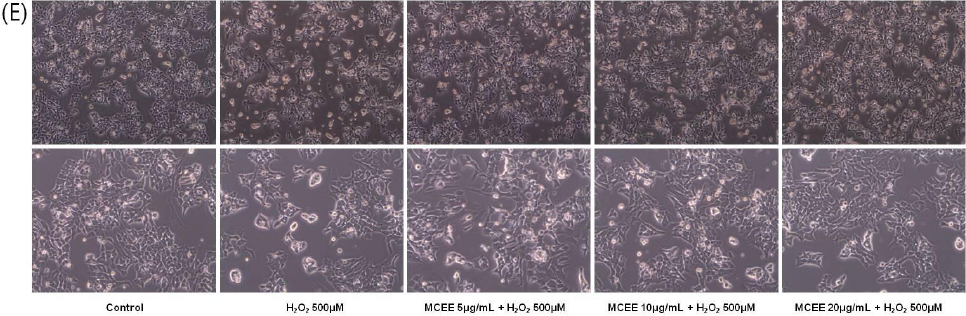
Figure 1. Effects of the Momordica charantia Ethanol Extract (MCEE) on the cell viability of and the cytotoxicity in SK-N-MC cells treated with H 2 O 2 . The cell viability was measured with the CCK-8 assay. SK-N-MC cells were treated with H 2 O 2 (100–800 μM) ( A ) and the MCEE (1–100 μg/mL) ( B ) for 24 h. ( C ) Cells were pretreated with the MCEE (5–40 μg/mL) for 24 h and then treated with H 2 O 2 (500 μM) for 4 h. ( D ) Cytotoxicity was determined with a lactase dehydrogenase (LDH) activity assay. ( E ) The morphological change of SK-N-MC cells was observed using a microscope (magnification 40× (upper)/100× (lower)). The cell viability was calculated as a percentage (%) of the control ( A – D ) and expressed as the means ± standard deviation (S.D.) ( n = 3). * p < 0.05; ** p < 0.01; *** p < 0.001 compared with the untreated control cells; # p < 0.05; ## p < 0.01 compared with only H 2 O 2 -treated cells. +, treatment; -, non-treatment.